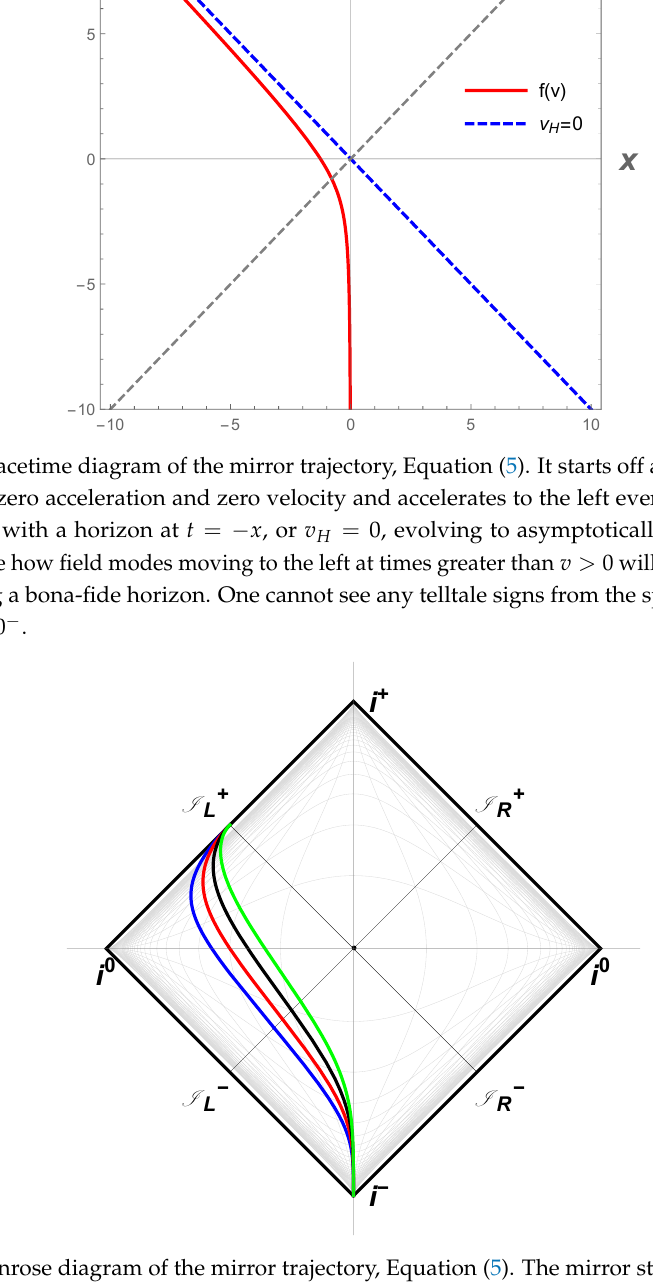
Figure 2. A Penrose diagram of the mirror trajectory, Equation (5). The mirror starts at rest at spatial position x = 0 when advanced time is v = − ∞ . It begins to accelerate and as v → 0 − , the velocity approaches the speed of light, and a null horizon forms. The proper acceleration reaches a maximum and then vanishes as v → 0 − . Because the acceleration is zero as v → − ∞ this this mirror asymptotically inertial. The various colors correspond to different maximum